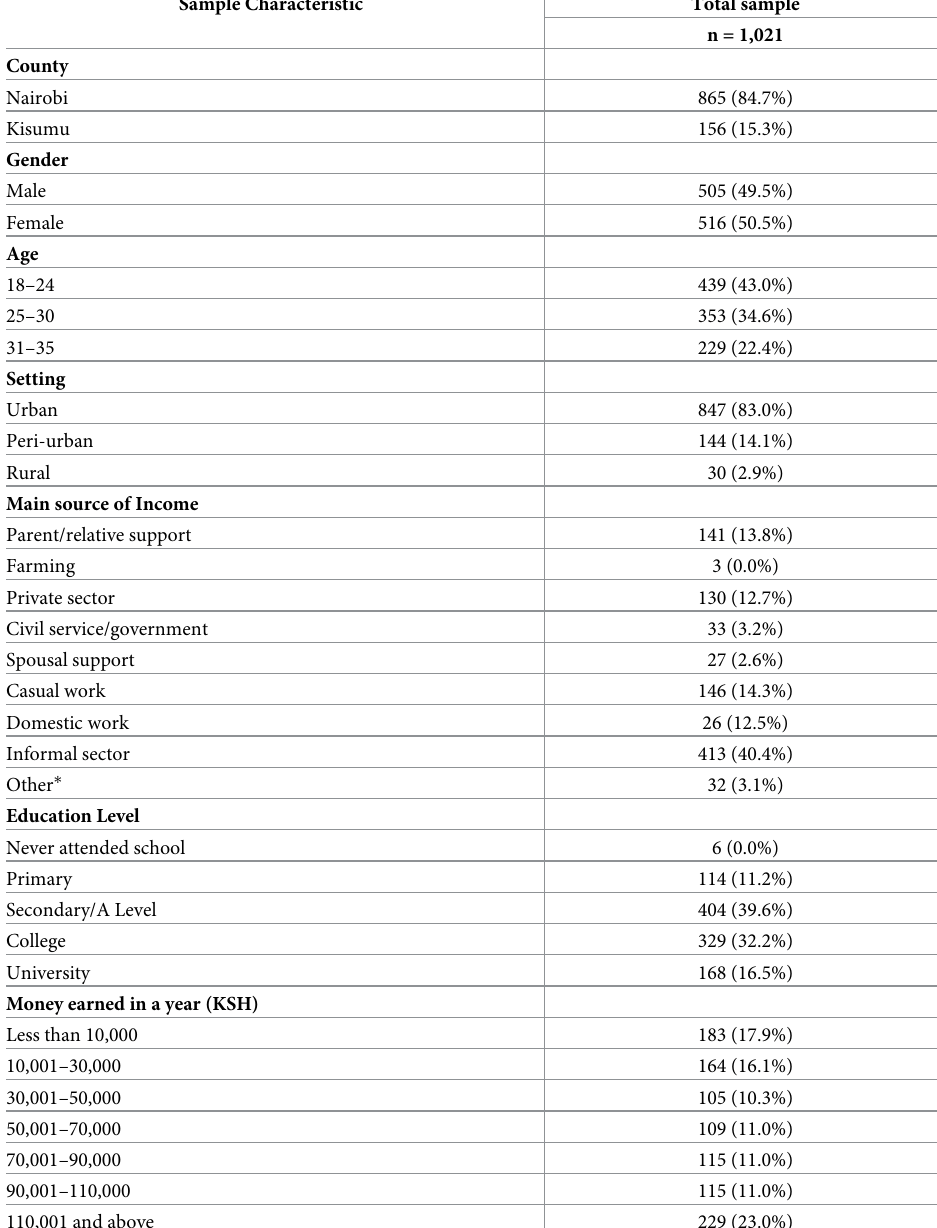
Table 1. Final sample